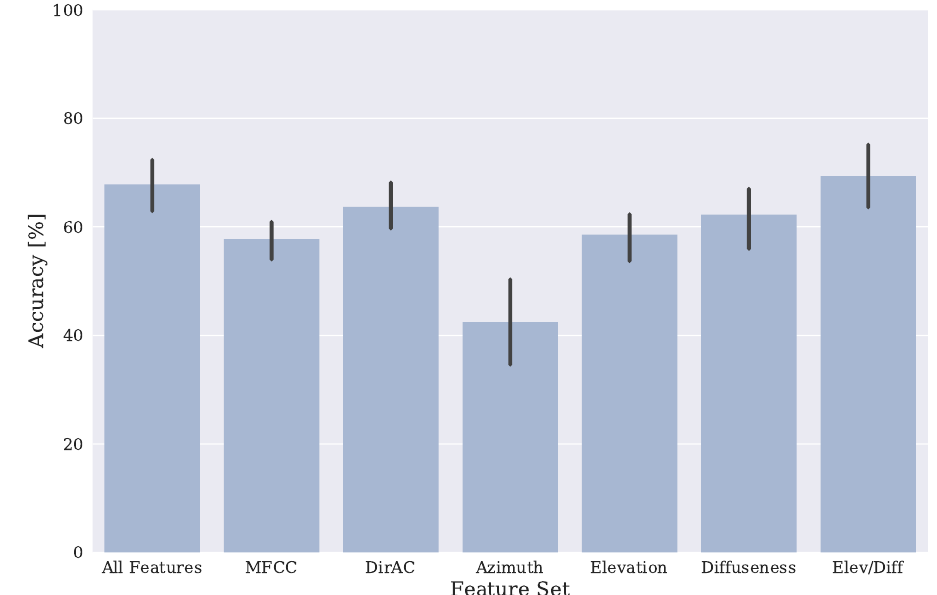
Figure 2. Mean and standard deviation classification accuracies across all folds for the entire dataset using various different feature sets (from [39]). MFCC: Mel-frequency cepstral coefficient; DirAC: directional audio